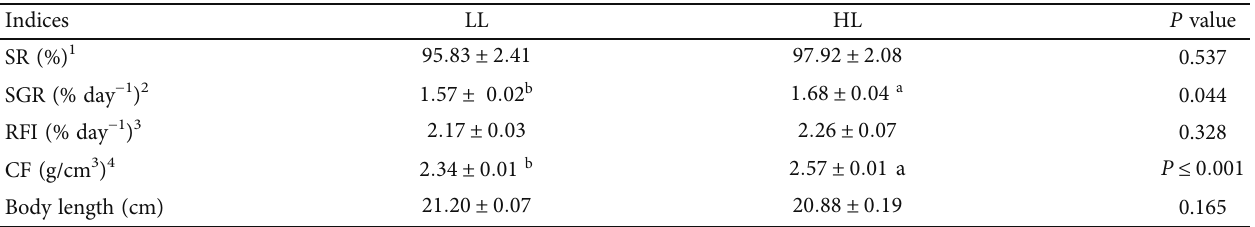
Within the same row, values with di ff erent superscripts are signi fi cantly, di ff erent (Independent t -test, P < 0 : 05 ). 1 SR ð survivalrate, % Þ = 100 × finalfishnumber /initialfishnumber . 2 SGR ð specificgrowthrate, % day − 1 Þ = 100 × ½ Ln ð finalbodyweight Þ − Ln ð initialbodyweight Þ /days . 3 RFI ð relativefeedintake, % day − 1 Þ